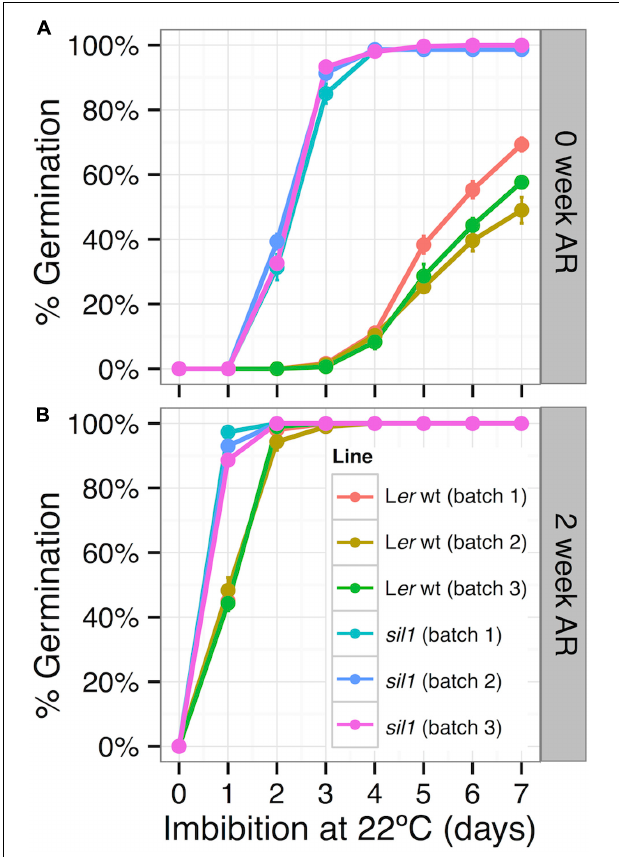
FIGURE 10 | A germination screen was performed to compare germination of sil1 and L er wt harvested at near maturity. Seeds were germinated at two timepoints, (A) freshly harvested (0 week AR), and (B) 2 weeks old (2 weeks AR). Three biologically independent batches of seed were assayed to clearly capture the HDA6 loss of function phenotype in sil1 . To minimize dormancy release, seeds were placed directly at 22 ◦ C and germination was scored daily. Freshly harvested sil1 seed germinated more efficiently than wild-type, both at 0 and at 2 weeks of after-ripening.